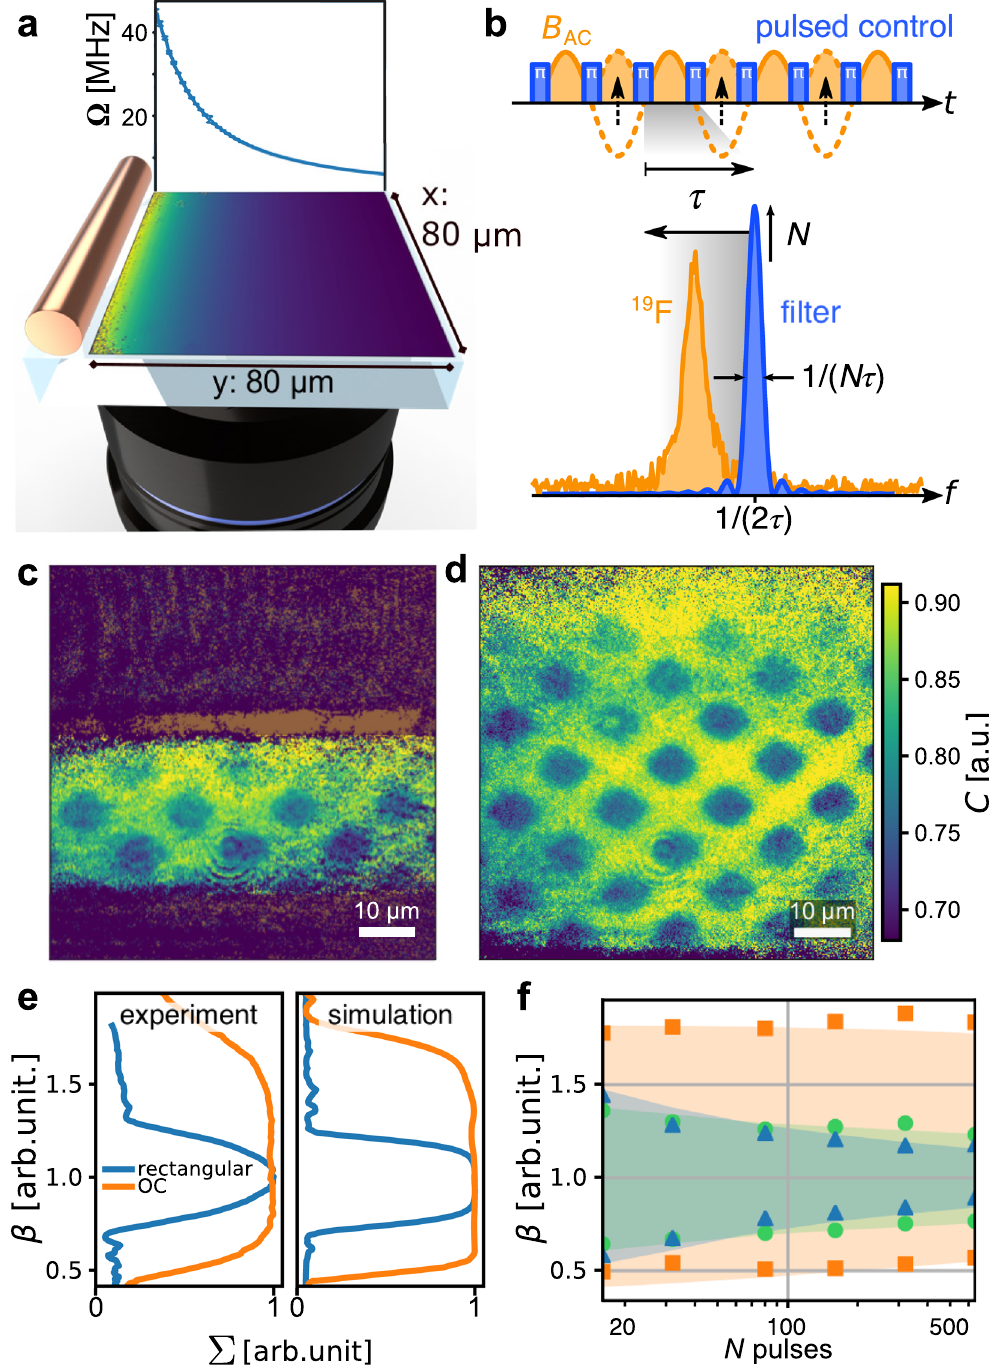
Figure 1. Experimental setting. ( a ) A 20 μ m thick wire for applying microwave control fields was placed next to the field of view of the magnetic imager. The y − 1 decay of the field amplitude away from the wire resulted in a range of NV Rabi frequencies across the field of view. ( b ) DD lock-in sensing utilises a train of N π -pulses to lock into a signal with period 1/ f = 2 τ . This creates a filter which scales in width as 1/( N τ ) and in height as N . ( c , d ) Lock-in MRI of 19 F nuclei in patterned CaF 2 on the diamond surface (dark blue squares in the image) using rectangular and optimal control pulses, respectively. The MW wire was located parallel to the horizontal edge at the bottom, outside of the field of view. While the gradient was steep at the bottom of the image, it was moderate at the top, leading to a gradual loss of contrast at the top of the effective range, where the fidelity of the decoupling decayed. ( e ) Experimental and simulated decoupling efficacy ∑ across the gradient (averaged along x ) for N = 320 pulses. ( f ) Experimental width (FWHM of profiles as in e) of the range within the gradient covered by XY16- N using rectangular (triangles), Knill (circles) and optimal control pulses (squares). Shaded areas correspond to results of the